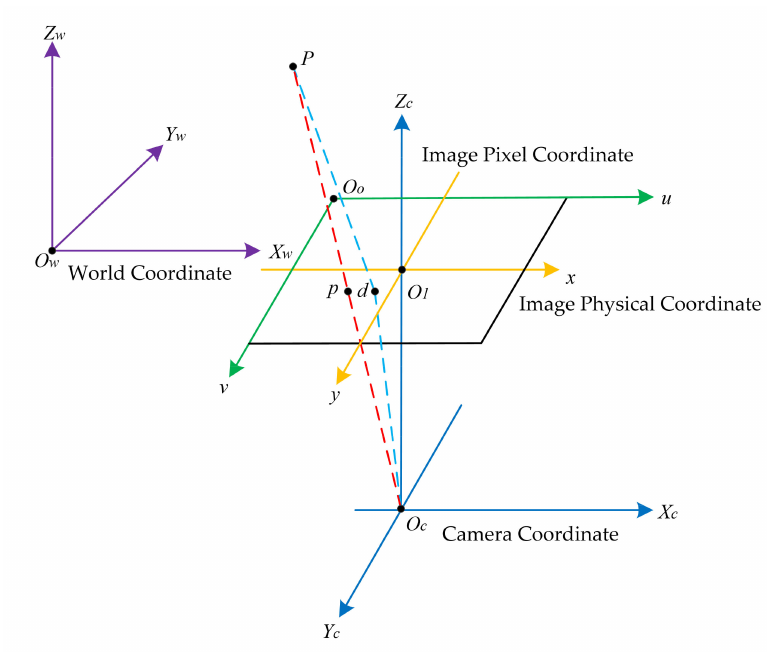
Figure 1. The geometric relationships between coordinates when the image is distorted.